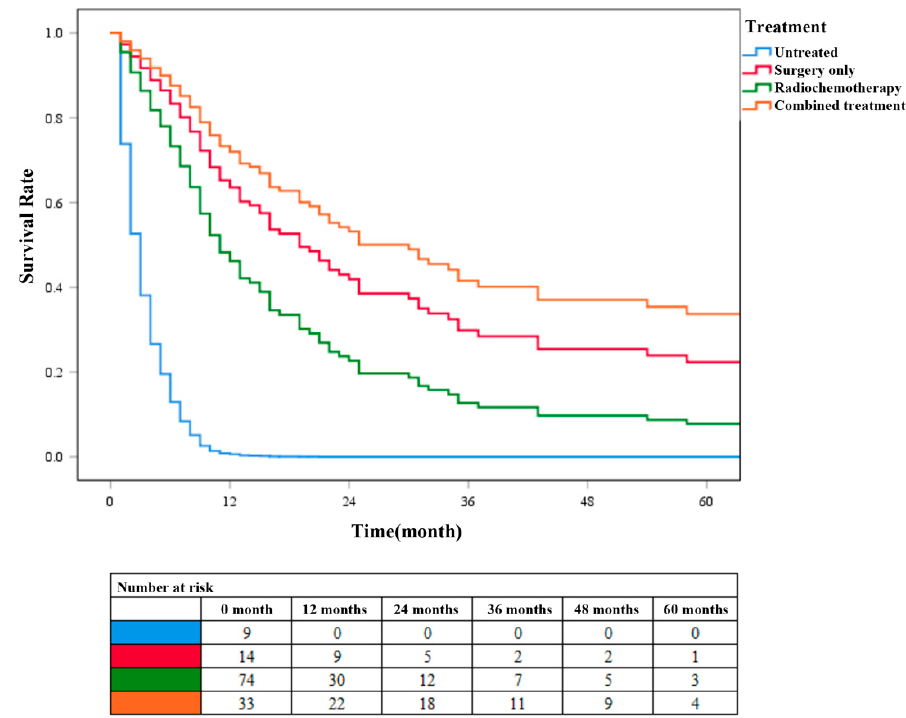
Figure 5. COX survival curves for different treatment groups of patients with ADSC.